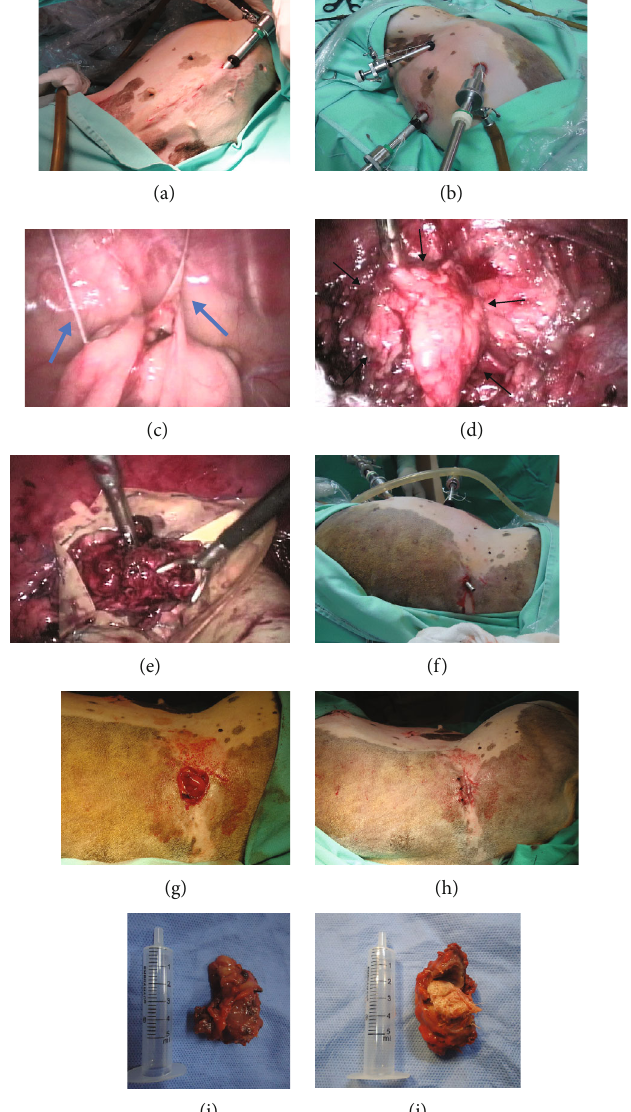
Figure 1: Laparoscopic diagnosis and treatment of gossypiboma in a female dog. (a) Placement of the fi rst port (11 mm) in the ventral midline. (b) After lateralisation of the patient, two other trocars (6 mm and 11 mm) were positioned laterally to the fi rst one in triangulation. (c) Laparoscopic aspect of the gossypiboma is envolved by the omentum; blue arrows indicate fi brous adhesions with the abdominal wall. (d) Gossypiboma (black arrows) after adhesiolysis; K: kidney. (e) Introducing gossypiboma into the tissue removal bag. (f) Cannula passage through the fi stula after its hydrodynamic debridement. (g) Aspect of the chronic wound associated to the fi stula after surgical debridement and laparoscopic positioning of the omentum through the muscular wall. (h) Aspect of the sutured wound. (i, j) Macroscopic aspect of gossypiboma before and after opening the fi brous tissue surrounding the surgical